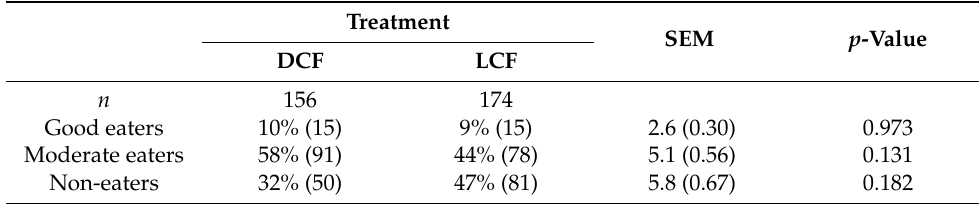
Table 3. Percentage of good eaters, moderate eaters and non-eaters in piglets receiving either dry (DCF) or liquid creep feed (LCF). Categorization was based on faecal swabs day 18, 21 and 24 postpartum with good and moderate eaters categorized as eaters on 3 or 1–2 samplings days, respectively, where non-eaters were the pigs never categorized as eaters on either of the sampling days.